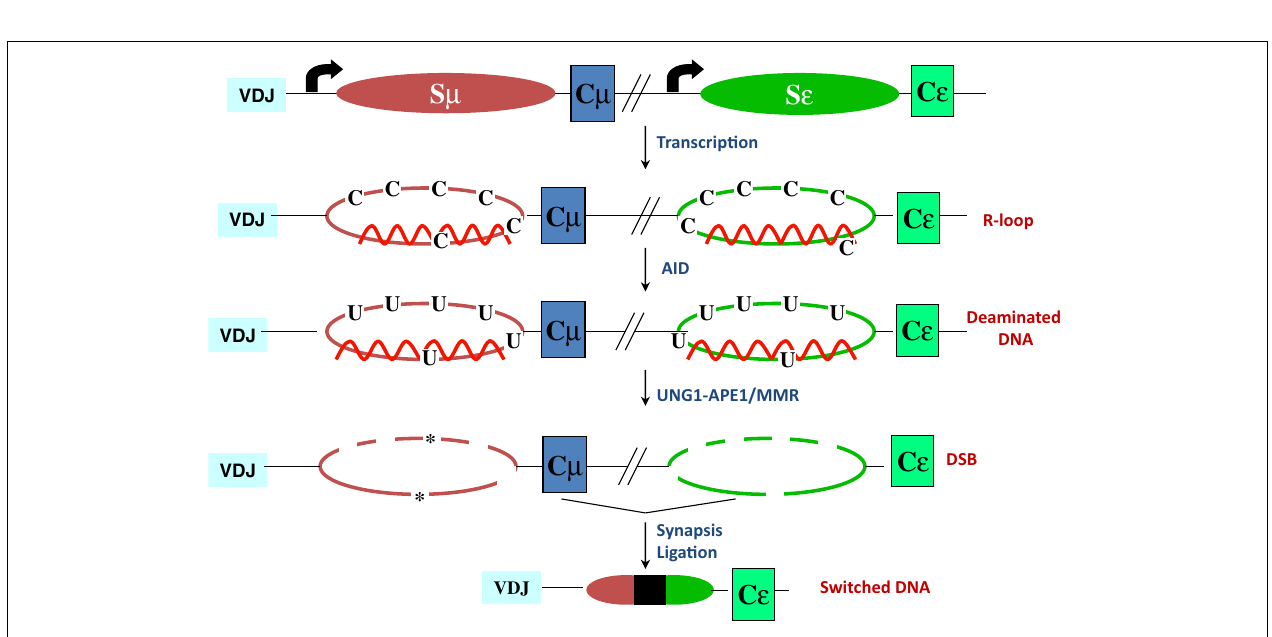
FIGURE 2 | R-loop-based model for CSR .Transcription through S regions generates R-loop structures in which the RNA stably hybridizes to the template strand, displacing the non-template strand as ssDNA. AID activity at R-loops generate uridines in the DNA, which are subsequently processed by BER and MMR proteins to ultimately generate DSBs. End-joining of DSBs completes CSR. Asterisks represent nicks close to each other on opposite strands.